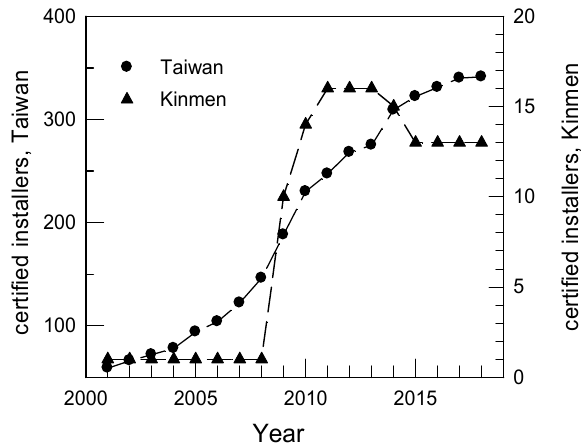
Figure 10. Historical data for certified installers in Taiwan and Kinmen County.